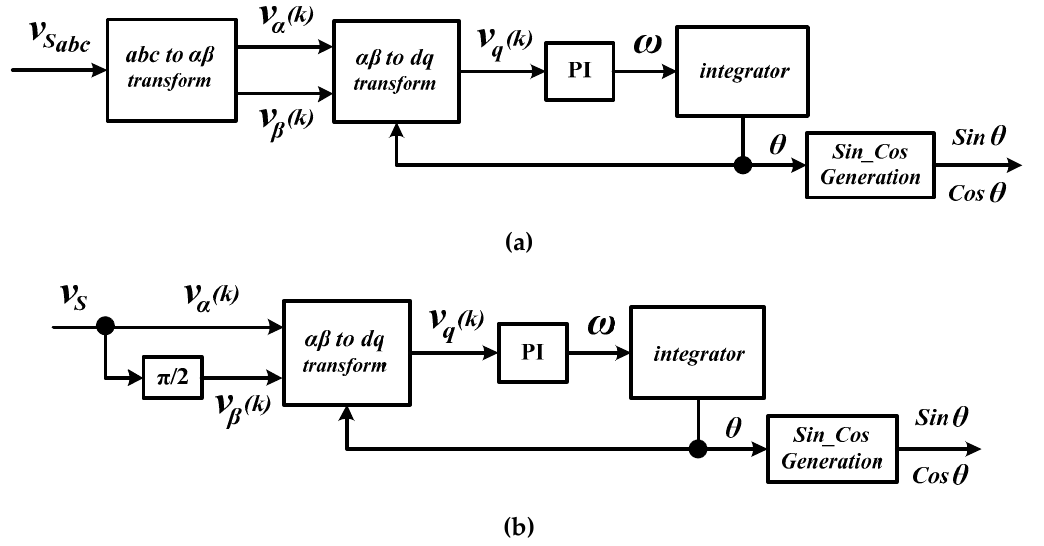
Figure 5. Control structure of synchronous reference frame (SRF)-PLL technique for ( a ) three-phase [10,53,54,73] and ( b ) single-phase [55,73,74]